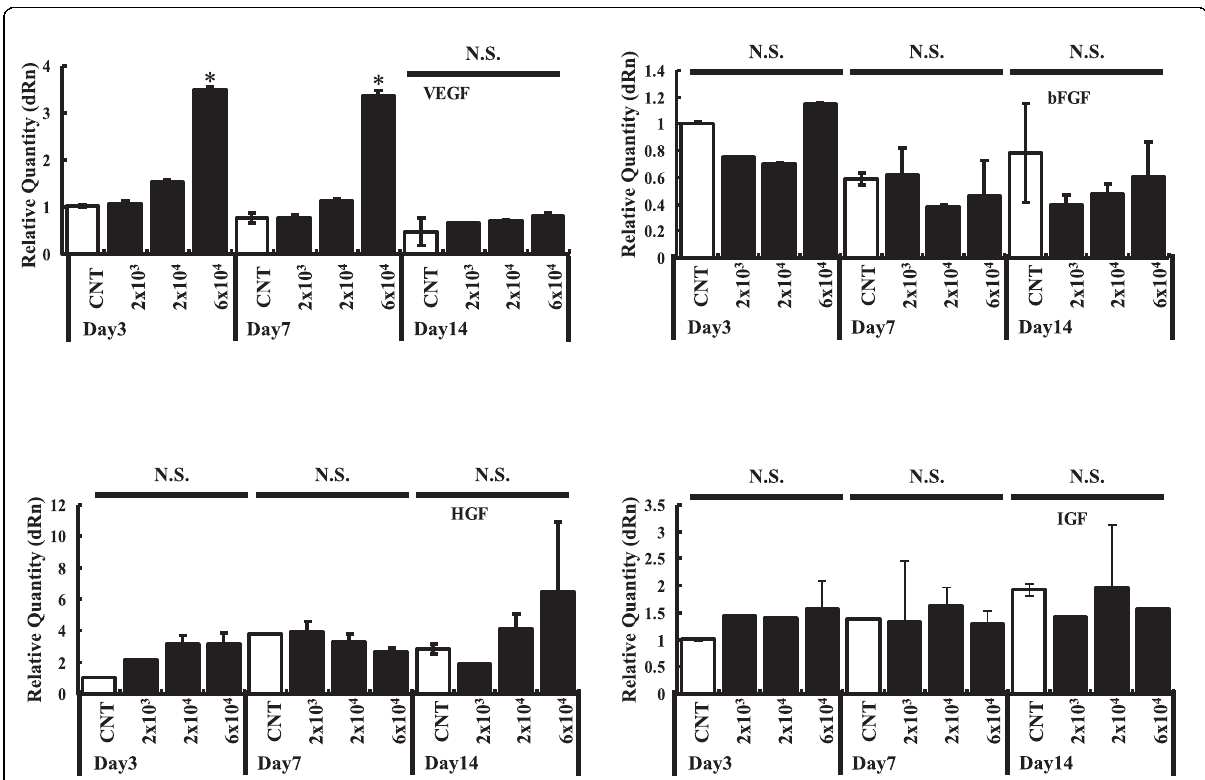
Figure 5 Flk-1+ cell implantation stimulated VEGF, basic FGF, HGF and IGF expression in ischemic tissue . VEGF, basic FGF, HGF and IGF synthesis in ischemic hind limb muscles was determined by real-time RT-PCR following transplantation of the Flk-1 + cells (2 × 10 3 , 2 × 10 4 or 6 × 10 4 cells) or PBS-injection as the control(CNT). Results are expressed as the level of VEGF, basic FGF, HGF and IGF mRNA to day three control. GAPDH mRNA levels were used as the internal control. *P < 0.05 6×10 4 vs. CNT at each day (n = 4 in each groups). N.S. = not significant difference between groups at same